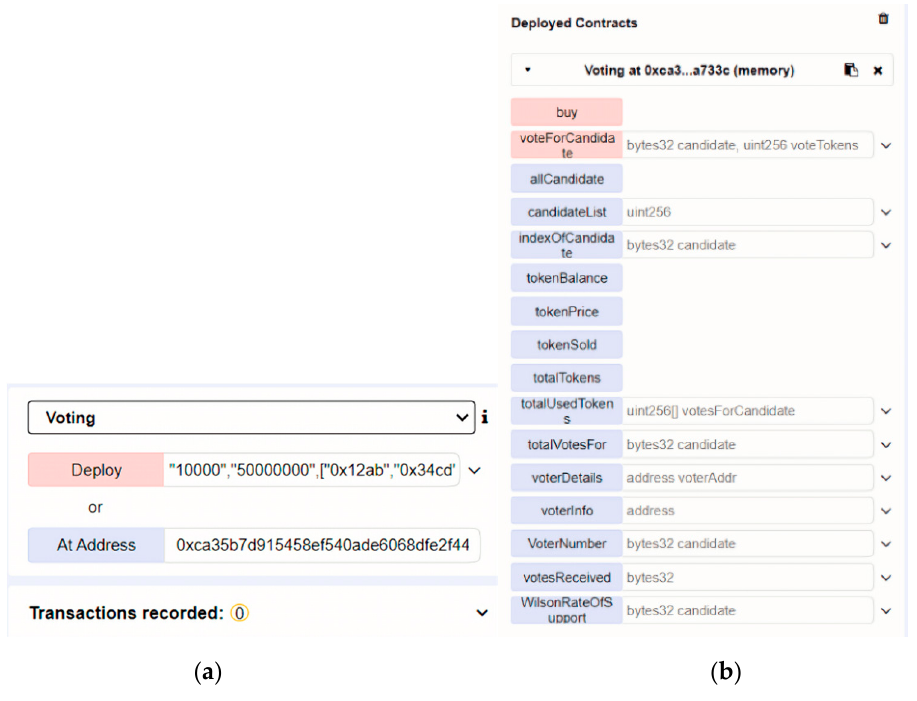
Figure 4. Showing the deployment and calling interface of the smart contract: ( a ) Deploying the smart contract; ( b ) Calling the smart contract.